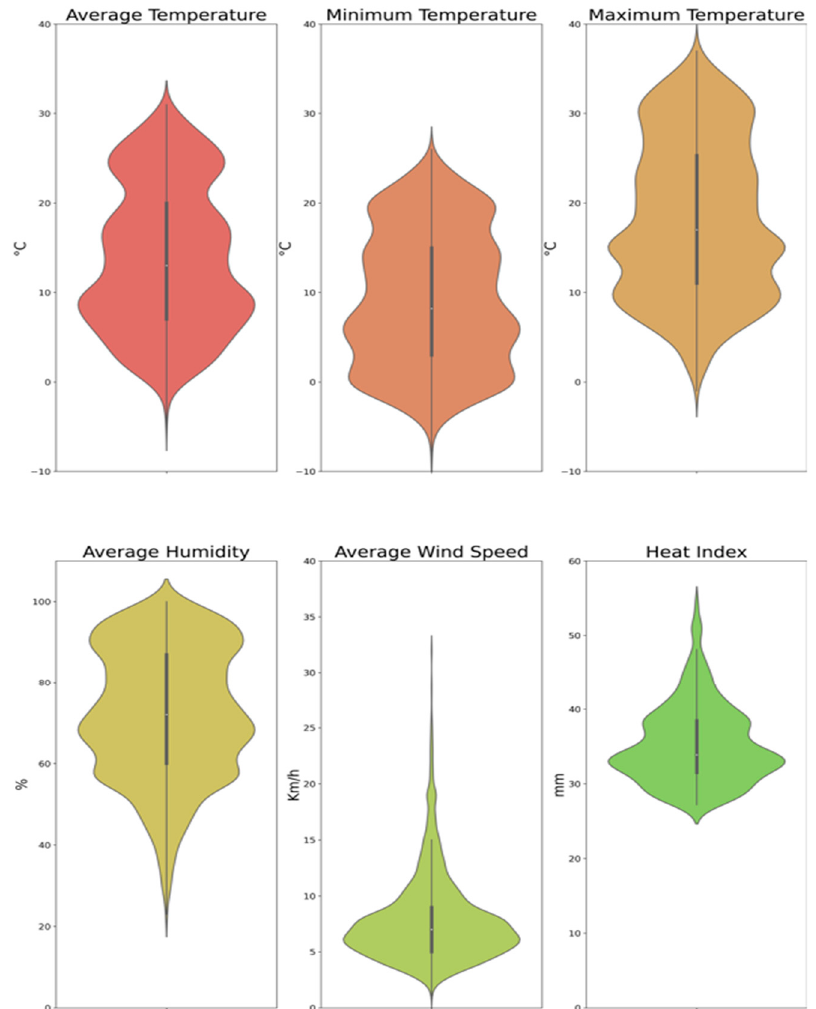
Figure 1. Distribution of meteorological covariates.